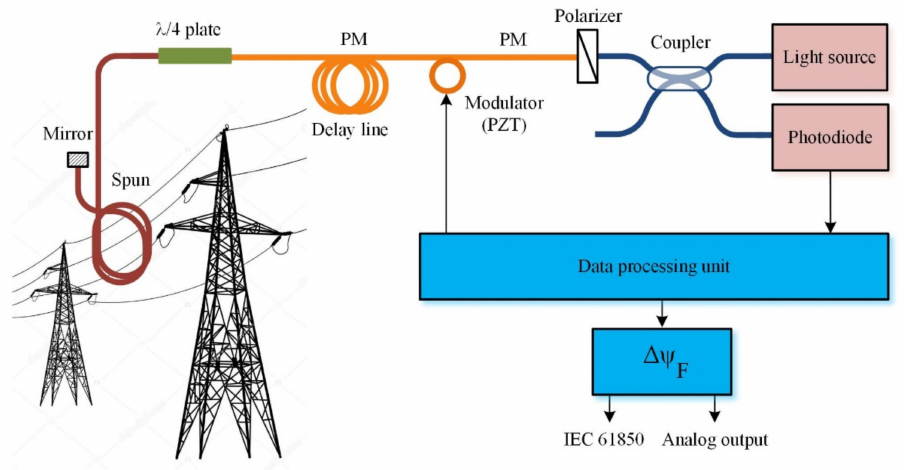
Figure 1. Optical scheme of fiber optic current sensor